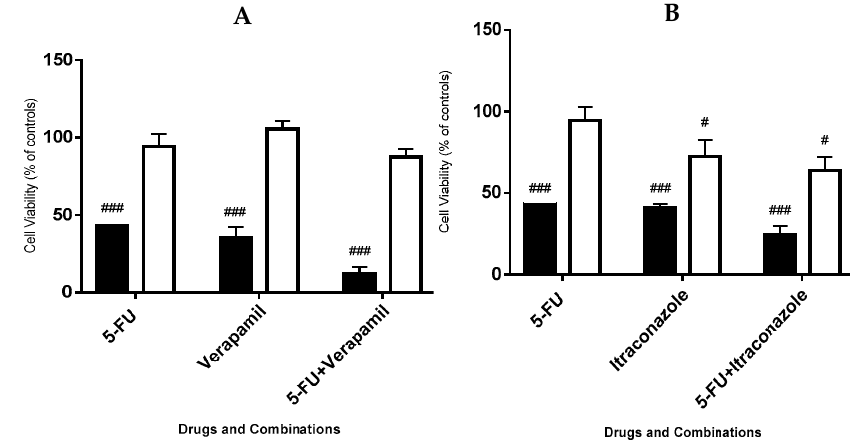
Figure 2. Effect of 5-FU, verapamil ( A ), itraconazole ( B ) and respective combinations with 5-FU on the viability of MCF-7 cells (left, black bars) and MCF-10A cells (right, white bars). Each drug and combination were added in fresh medium, in sextaplicates. Results are presented as mean ± SEM and represent the viability of cells (% of control) of 3–4 independent experiments ( n = 3, 4). ### p < 0.001 and # p < 0.05 vs. respective controls.